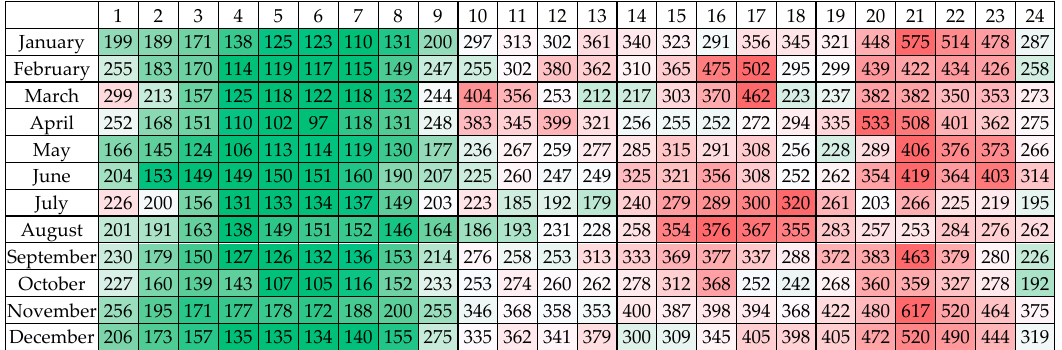
Figure 11. The aggregate profile of average power: Saturdays. (Green: low; White: medium; Red: high).